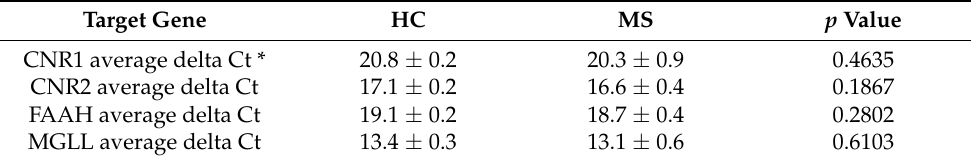
Table 5. Constitutive expression of CNR1 , CNR2 , FAAH, and MGLL mRNA in PBMCs from HCs and